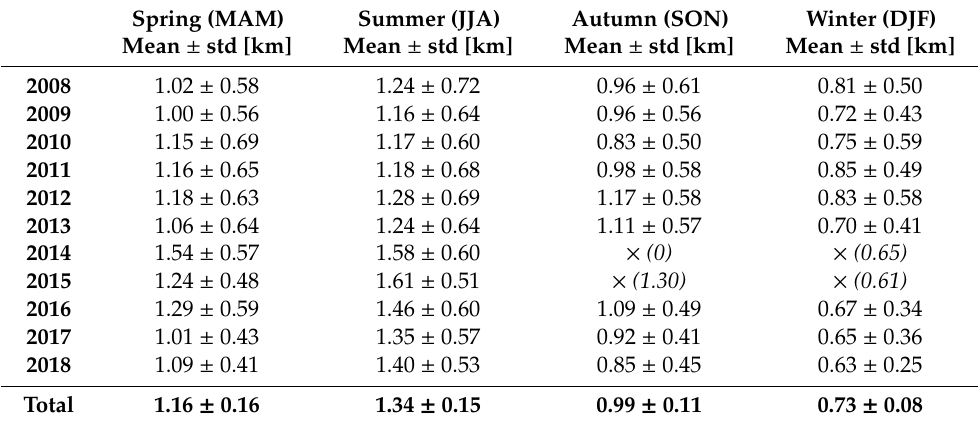
Table 4. The seasonal mean ABLH values obtained from the PollyXT lidar and the CHM15k ceilometer data using the wavelet covariance transform (WCT) method for observations conducted in all-weather conditions over Warsaw, within the period from 2008 to 2018. Mean values for seasons with less than 10 measurement cycles are indicated in italics, being regarded as statistically not representative. Merging and homogenization were applied to lidar data from November 2013 to December 2018. Spring (MAM) Summer (JJA) Autumn (SON) Mean ± std [km] Mean ± std [km] Mean ± std